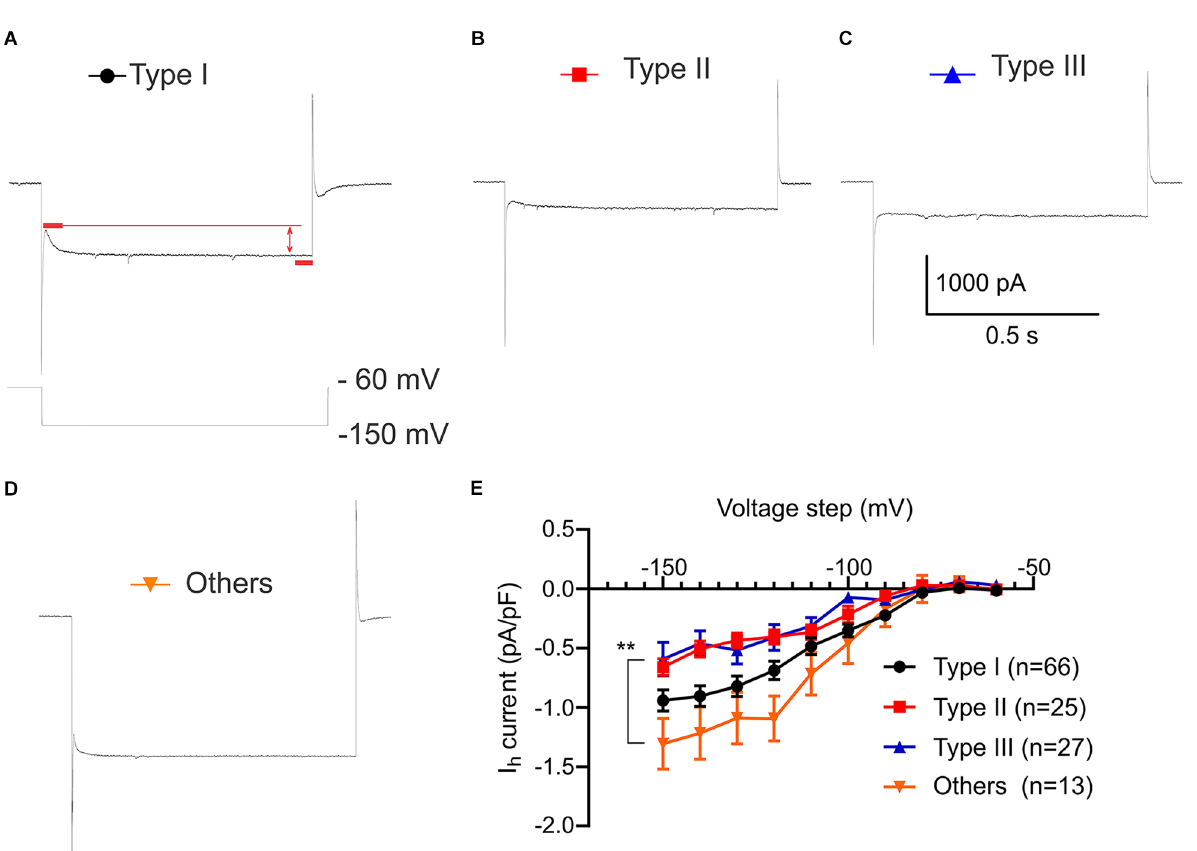
FIGURE4 Hyperpolarization activated current ( I h ) (pA/pF) of VTA projecting BNST neurons. I h recording protocol of voltage step from − 150 mV to − 60 mV. (A–D) Sampletraceof I h ofTypeI-IIIandType“Others”at − 150mVstep. (E) Comparisonof I h showsthatType“Others”hasasignificantlylarger I h compared to Type II and Type III . I h (pA) was normalized by capacitance (pF). A two-way ANOVA revealed that there was a significant interaction between the effect of neuronal types and voltage steps, F (27,1270) = 1.915, P = 0.0033. Tukey post-hoc test revealed that Type “Others” had significantly larger I h density (pA/pF) than Type II and Type III at − 120 mV through − 150 mV voltage steps (adjusted P = 0.0001, vs. Type